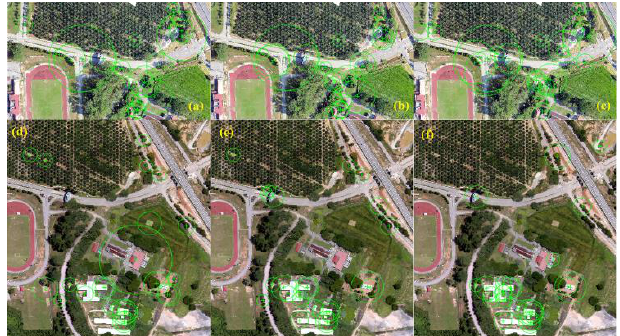
Figure 4. (a) UAV Band1, (b) UAV Band2, (c) UAV Band3, (d) LiDAR Band1, (e) LiDAR Band2, (f) LiDAR Band 3 (The green circles show the strongest feature points selected by